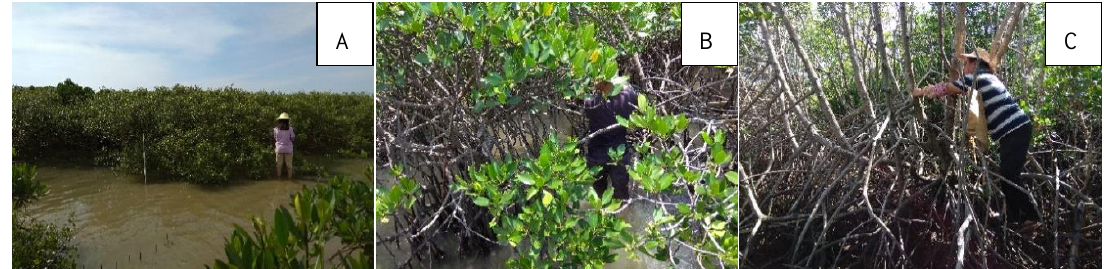
Figure 10. Illustrations of fieldwork challenges in mangrove habitat. This was conducted on Hainan Island: ( A ) walking barefoot in mangrove habitat; ( B ) field sampling in an R. stylosa community inundated by the tide; ( C ) measuring the diameter breast height in an R. apiculata community with dense prop roots at the bottom.